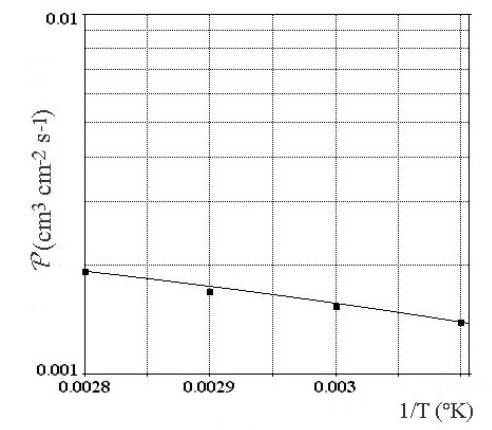
Figure 6. Effect of temperature for permeability in 9 wt % Y-Pd cathode membrane for